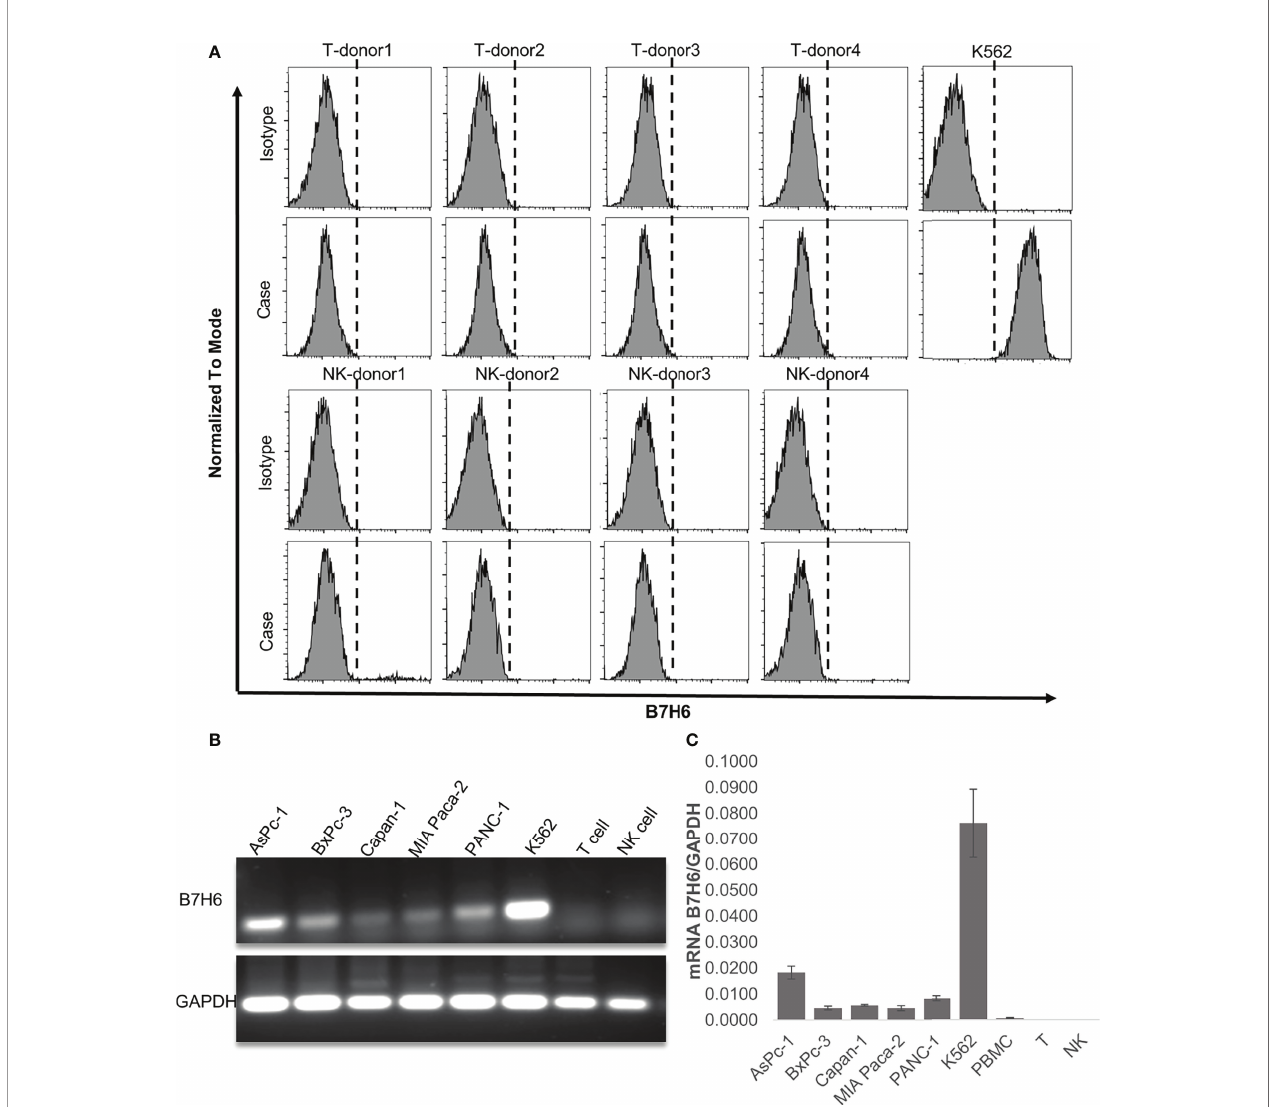
FIGURE 5 | B7H6 expression in human immune cells. (A) Surface expression of B7H6 on human T cells or NK cells from 4 healthy donors was detected with a Fortessa X20 fl ow cytometer; the K562 cell line was a positive control. (B) Representative gel pictures of the B7H6 RT-PCR product from pancreatic cancer cell lines, human T cells, and NK cells; the K562 cell line was a positive control. (C) qPCR of B7H6 mRNA expression in human peripheral blood mononuclear cells, T cells, and NK cells. Five different PC cell lines were analyzed, and K562 cells served as the positive control. Data from at least 3 independent experiments are shown as mean ±